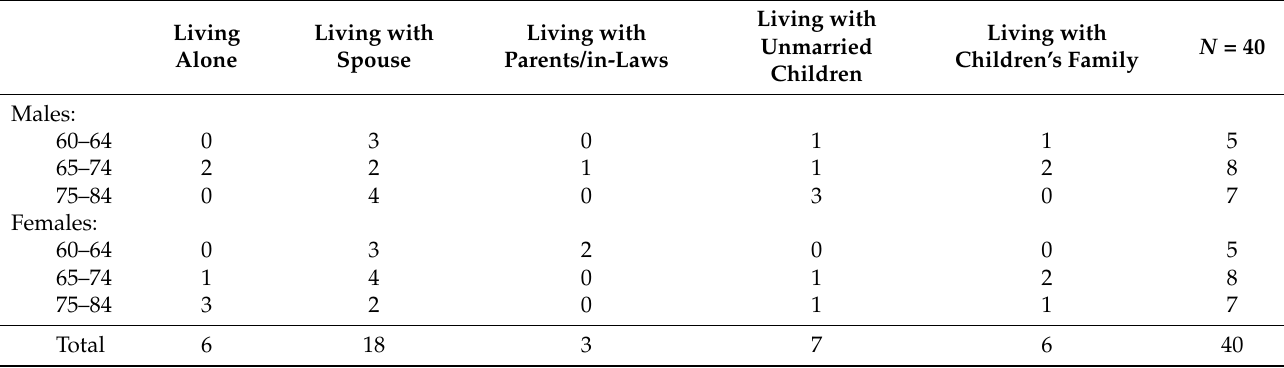
Table 3. Living arrangements of